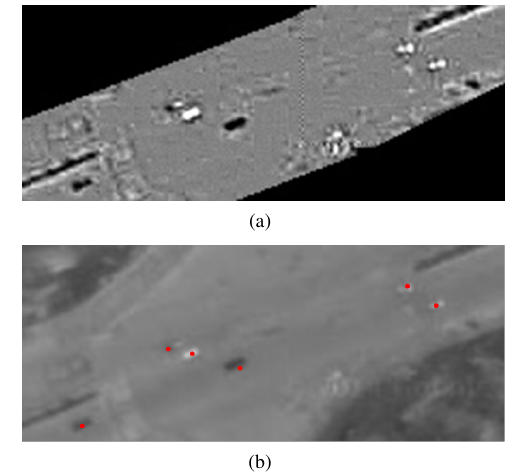
Figure 19: Illustration of local result.(a)Texture image. (b)Vehicle detection result is marked by red point, vehicles are well detected on concrete